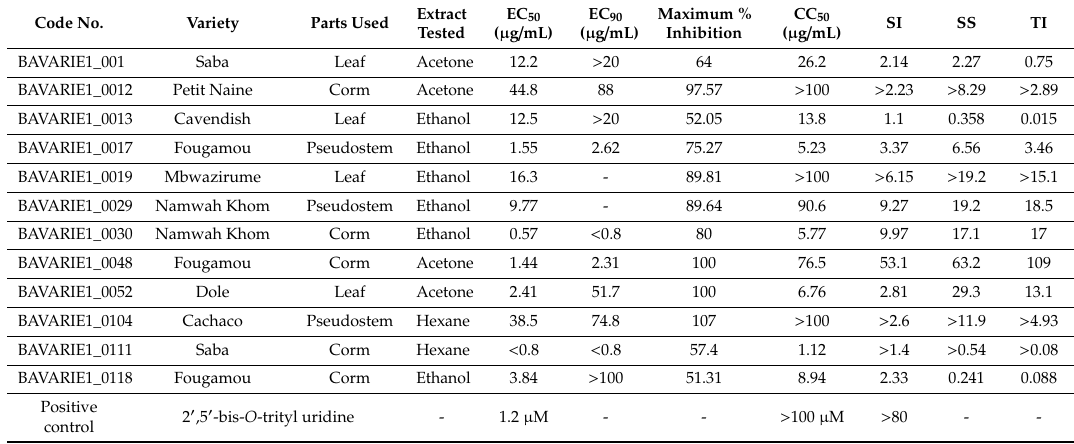
Table 3. Antiviral and cytotoxic activity of banana varieties against yellow fever virus. Code